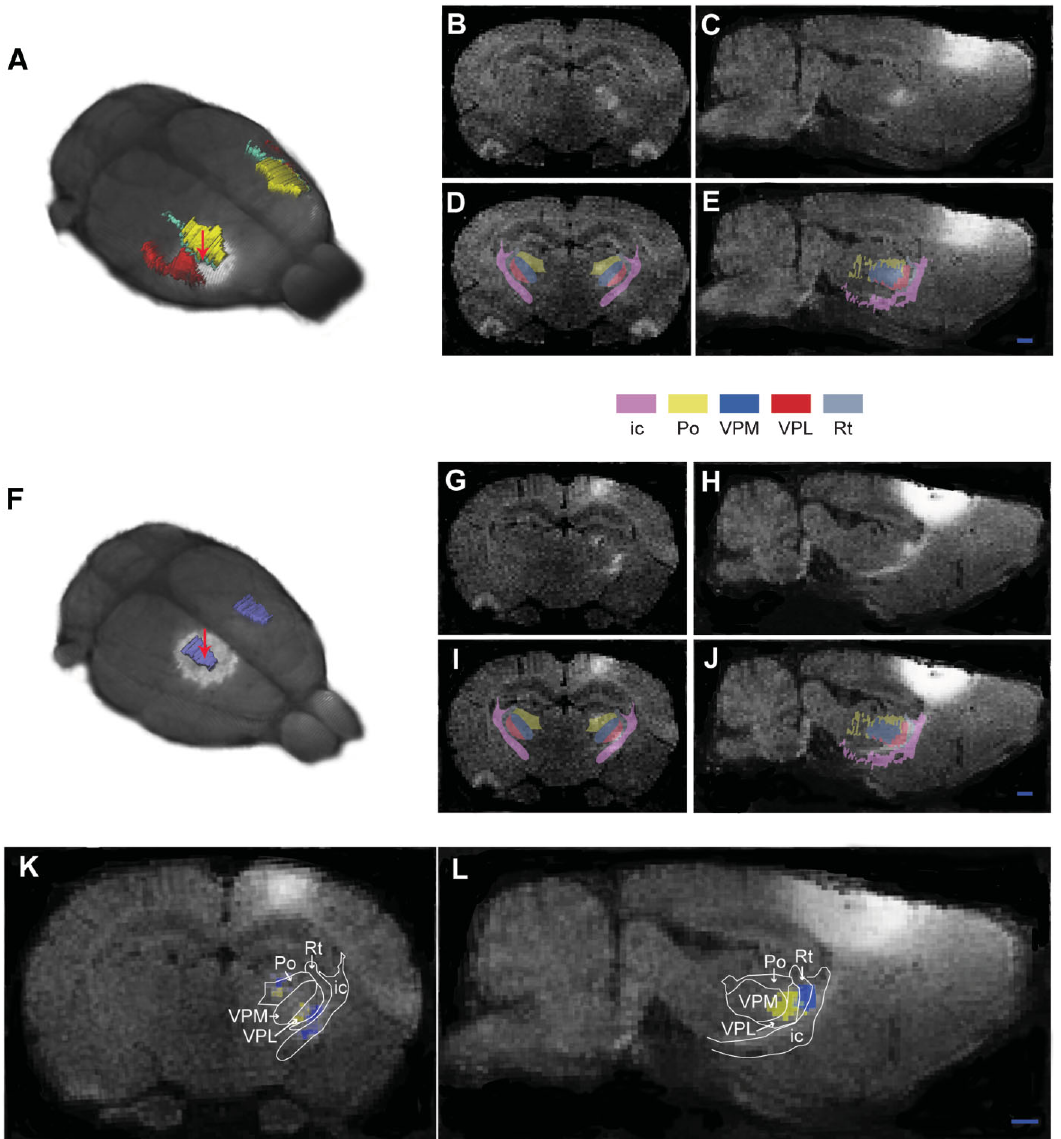
Figure 5. Corticothalamic topographical organization revealed by MnCl 2 /MRI tracing and 3-D atlasing . Two cases are shown, case 1 ( A–E ), in which MnCl 2 was injected in the dysgranular zone adjacent to the SI forelimb representation ( A ), and case 2 ( F–J ), in which MnCl 2 was injected in the hindlimb representation of SI. ( B, C and G, H ) Raw coronal and sagittal T 1 -weighted MRI images obtained 9hours after injection. ( D, E and I, J ) Corresponding images with overlay of selected reconstructed atlas structures. ( K, L ) Superimposed, pseudocolored images (case 1, yellow; case 2, blue) with an overlay of atlas derived boundary lines, demonstrating a somatotopical organization of the different signals within the Po and VPM. ic, internal capsule; Po, posterior thalamic